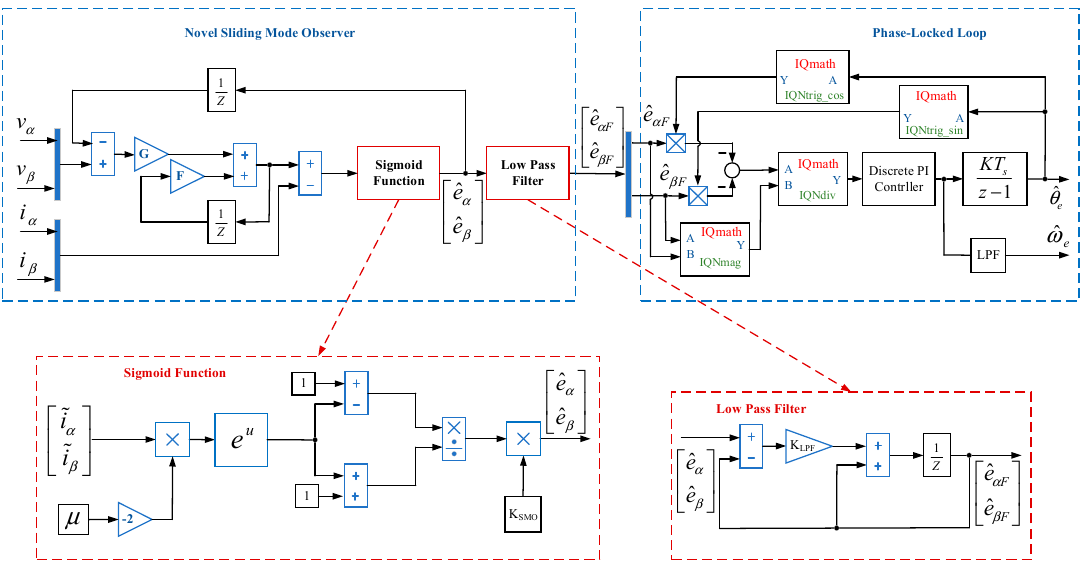
Figure 5. The block diagram of the novel sliding mode observer (SMO) with a phase-locked loop (PLL) in Simulink.